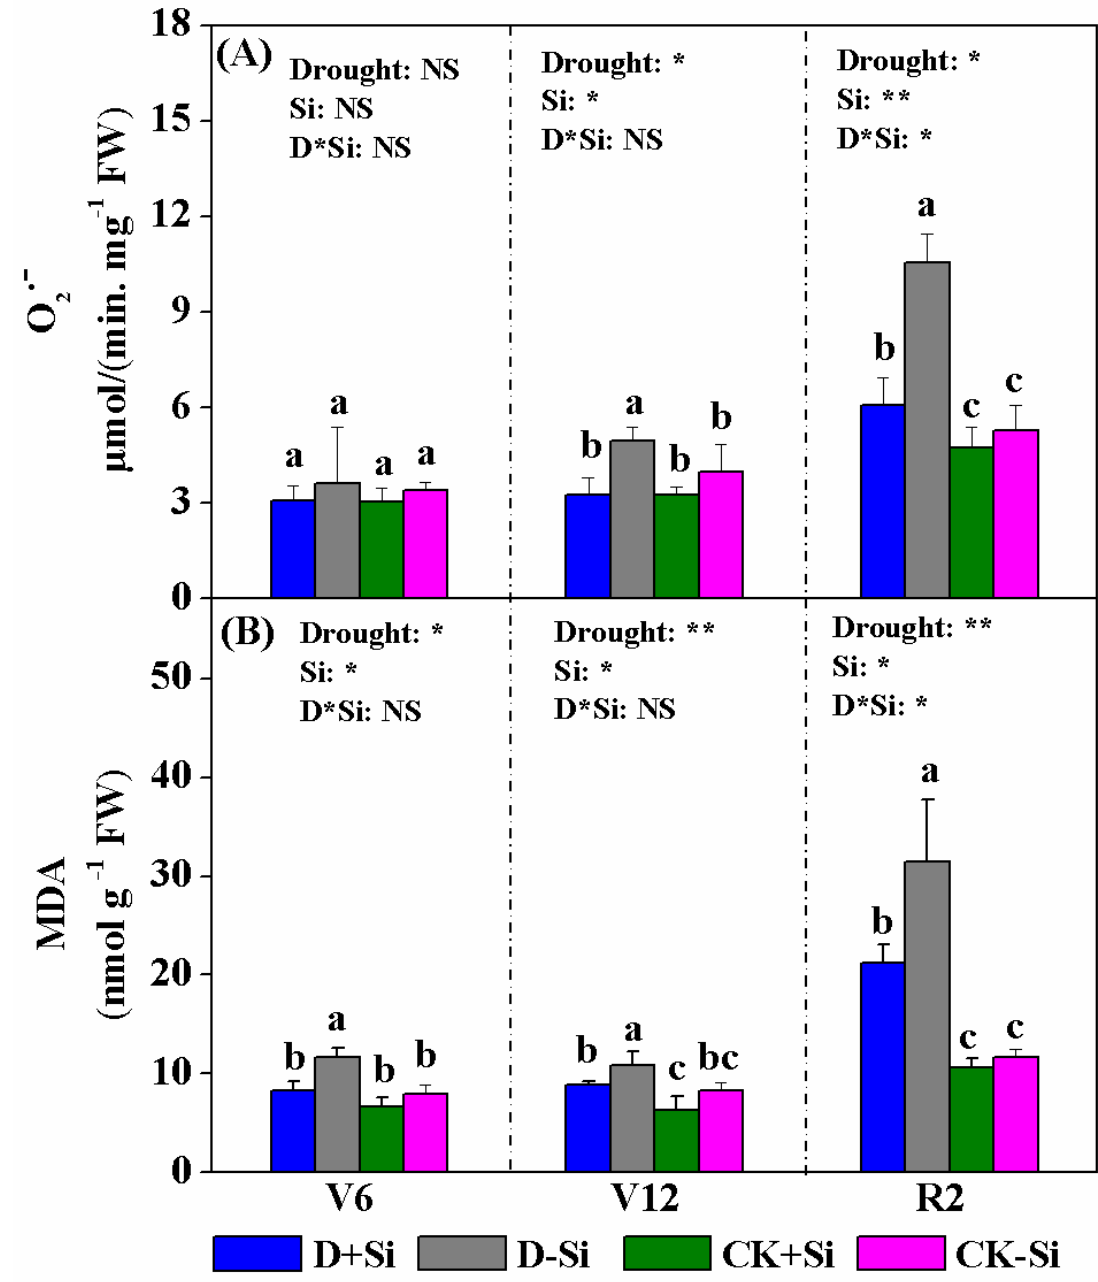
Figure 6. Effect of Si application on superoxide radical (O 2 ·− , A ) and MDA ( B ) contents in the maize leaves at the V6, V12, and R2 stages under drought and control conditions. V6, the 6-leaf stage; V12, the 12-leaf stage; R2, the blister stage; +Si, Si addition; -Si, no Si addition; D, drought stress; CK, well-watered control condition. Data are the means ± standard errors (SE) of three replicates, where n = 3 for O 2 ·− and MDA contents. Different letters (a, b, c) above the bars indicate statistical significance ( p ≤ 0.05). ** Significant at p ≤ 0.01; * significant at p ≤ 0.05; NS, no significant difference.